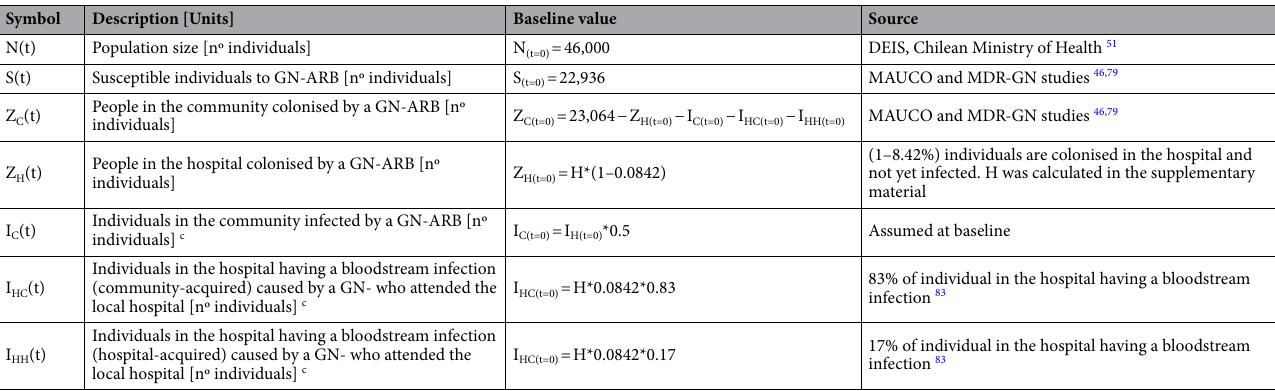
Table 1. Baseline conditions within the compartments. DEIS: Dirección de Estadísticas en Información en Salud; GN-ARB: gram-negative antibiotic resistance bacteria; MDR-GN: Multidrug resistant gram-negative, OECD: Organisation for Economic Co-operation and Development. Parameters were obtained from the literature and available resources from the Chilean government. Parameters follow the structure of Fig. 5 and Equations from the supplementary material. c We used the corresponding proportions for community and hospital-acquired infections from a study in the USA 83 . Chile and the USA have similar ARB rates according to OECD estimates 14 .